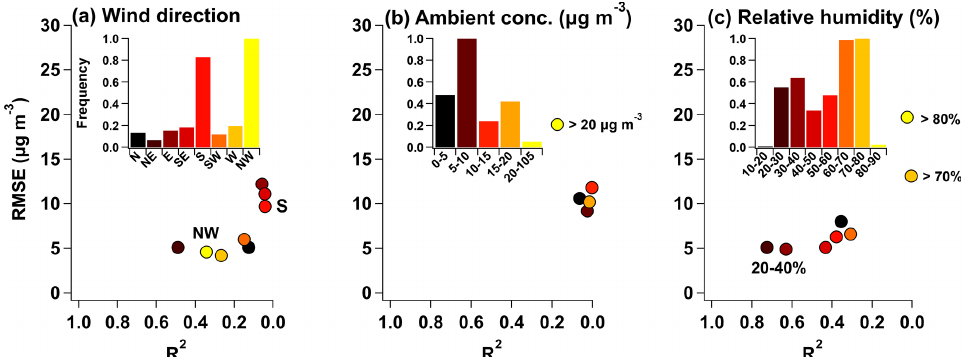
Figure 4. Performance comparison of the RH-corrected Alphasense OPC-N2 compared to the MicroPEM under different environmental conditions: (a) wind direction, (b) ambient concentration, and (c) relative humidity during colocation at the Village 2 site in Mulanje, Malawi. An individual data point represents the paired metrics (RMSE and R 2 ) for the OPC-N2 for a specific range of each condition. The histograms (inset) show the normalized frequency distributions for the ranges of each condition recorded during the colocation period. The colored markers in each panel correspond to the colored histogram bins. The metrics were calculated from 1h averaged RH-corrected OPC-N2 PM 2 . 5 concentrations compared to the MicroPEM filter mass-corrected nephelometer. RMSE is root-mean-square error, assuming the MicroPEM concentrations as the true values. R 2 is the coefficient of determination. The lower-left corner of each panel indicates the highest performance based on these